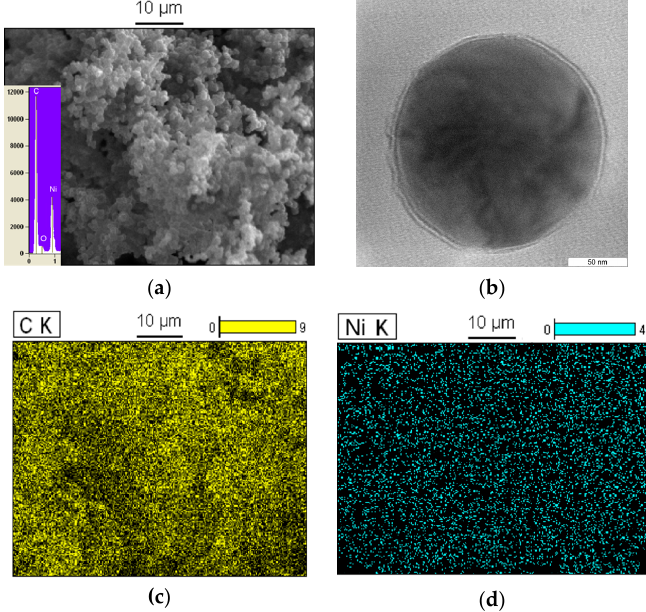
Figure 4. SEM/EDX image of Ni/C nanospheres ( a ); TEM image of Ni/C nanospheres ( b ); elemental mapping images of C at 950 °C ( c ) and Ni at 950 °C ( d ).